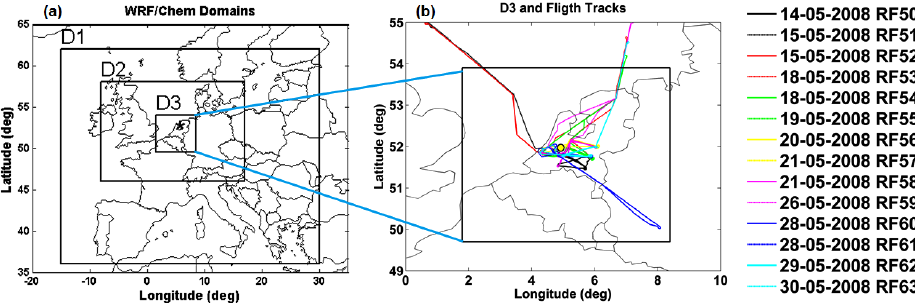
Figure 1. Panel (a) shows the three nested model domains used for simulations. D1 is 30km resolution, D2 10km, and D3 2km. The black star indicates the Cabauw supersite. Panel (b) is a zoom of D3 and shows the track of every flights used in this study, yellow circle represents Cabauw